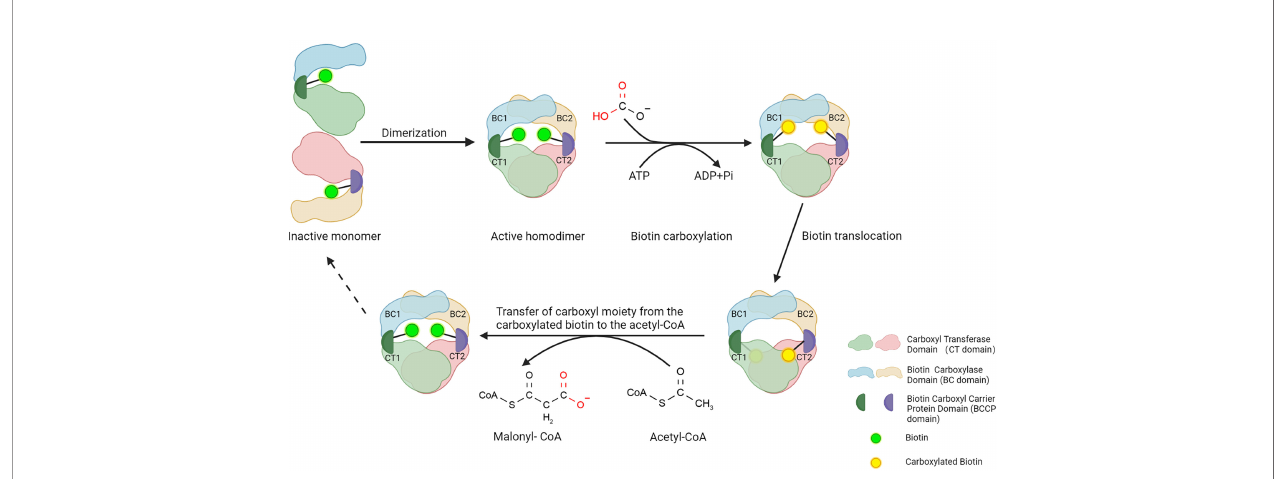
FIGURE 1 | Structure of ACC1 and function of three main domains. Three steps to a functional ACC1: First, the BC domain consumes ATP and catalyzes the carboxylation of biotin, in which bicarbonate serves as the donor of the carboxyl moiety. Subsequently, the BCCP domain transfers the bicarbonate moiety from carboxylated biotin to the CT domain of ACC1. Lastly, the CT domain catalyzes the carboxylation of acetyl-CoA carboxyl moiety, converting acetyl-CoA into malonyl- CoA. Created with